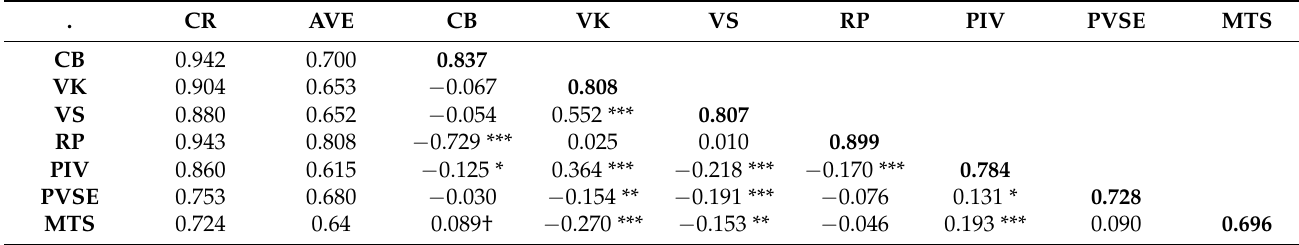
Table 3. Reliability, Validity and Discriminant